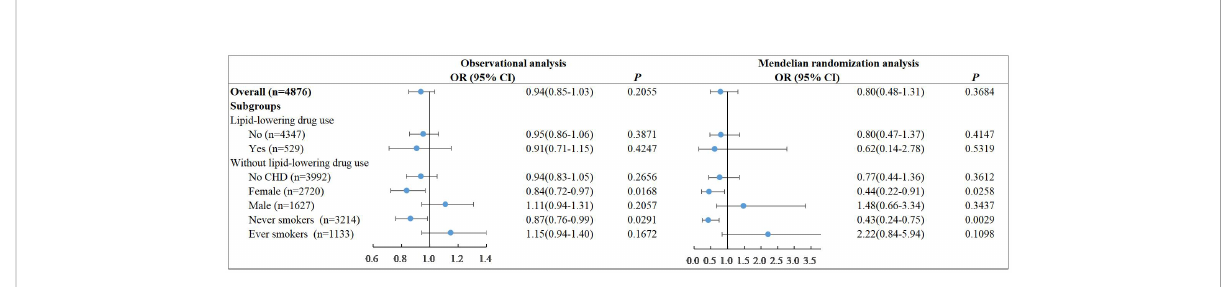
FIGURE 1 Linear associations of LDL-C with the risk of diabetes in observational analysis and MR